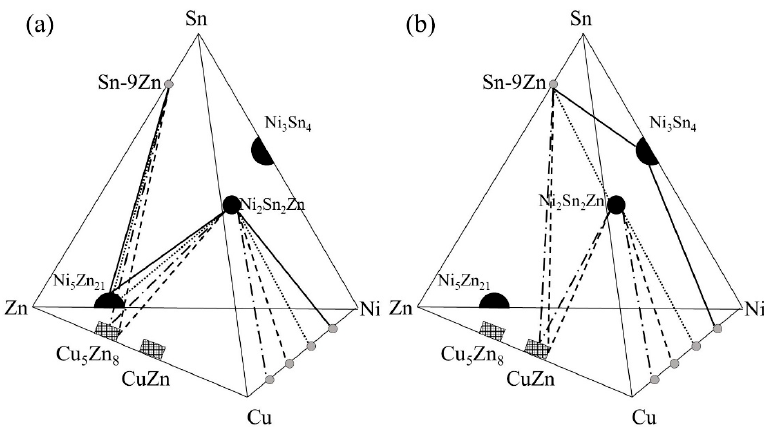
Figure 10. Two reaction stages of the Sn-Zn/Ni(Cu) joints superimpose on the Zn-Sn-Ni-Cu isothermal tetrahedron at 350 °C during ( a ) early stage; and ( b ) later stage.